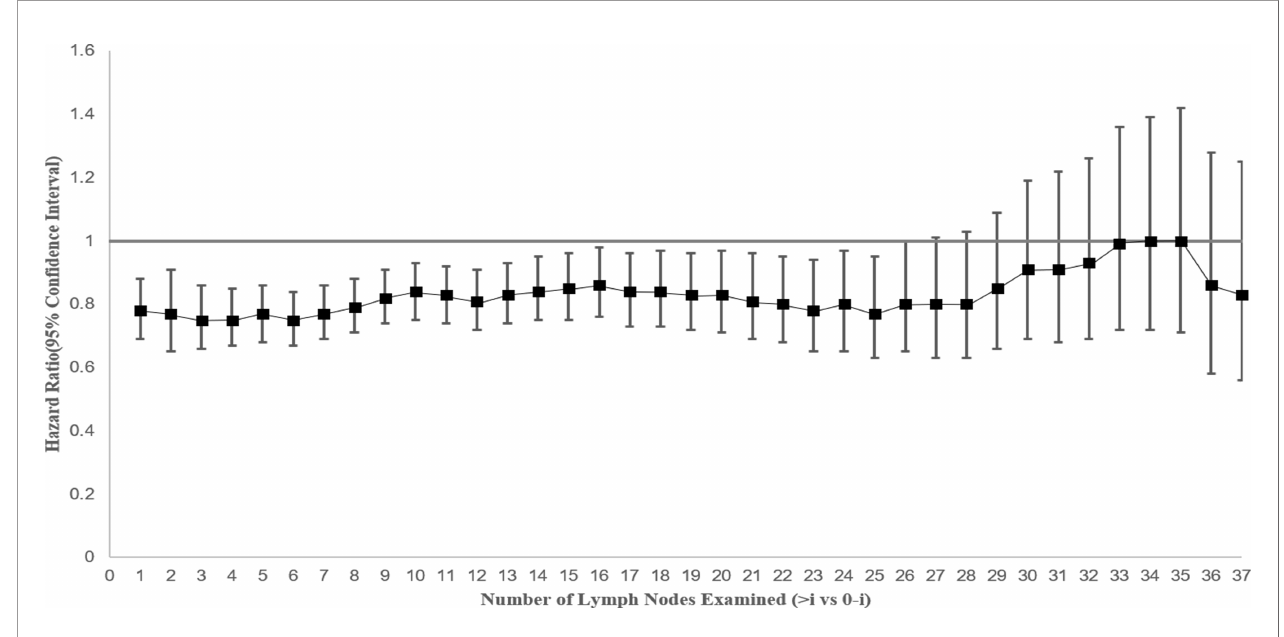
FIGURE 4 | Hazard for cancer-speci fi c survival and 95% con fi dence interval by extent of lymph node evaluation by comparing greater than “ i ” versus “ 0 to i ” lymph nodes (where “ i ” is the number of lymph nodes examined) among patients with stage IV